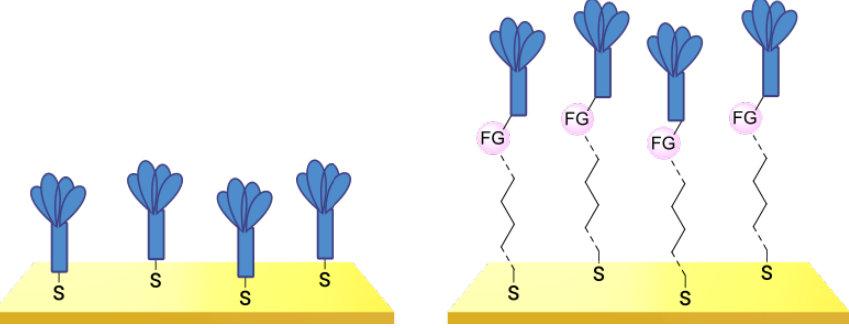
Figure 5. Comparison of direct SAM formation of thiol-containing biomolecules ( left ) and use of a thiol linker ( right ) for the immobilization of biomolecules at the surface of a metallic electrode.